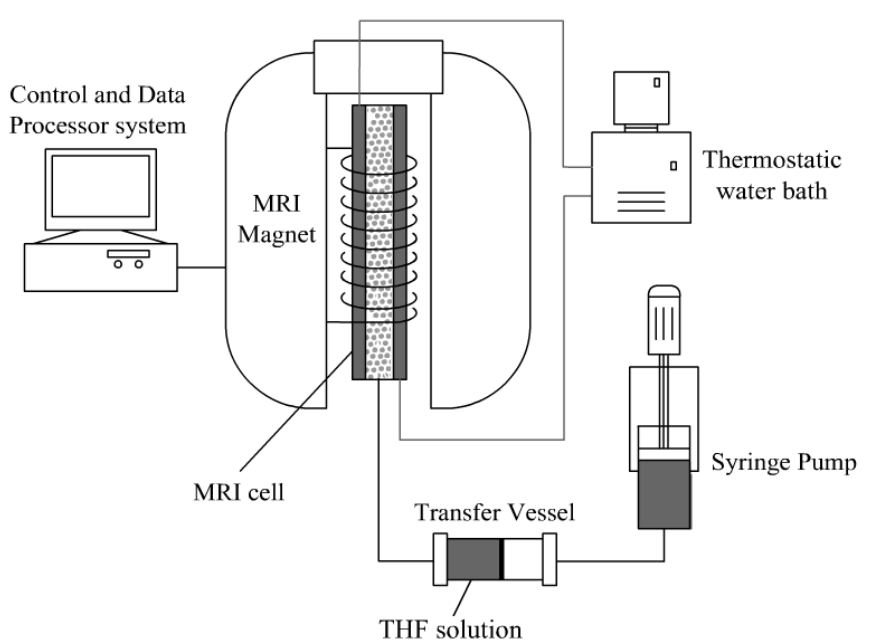
Figure 1. Schematic diagram of the experimental apparatus.